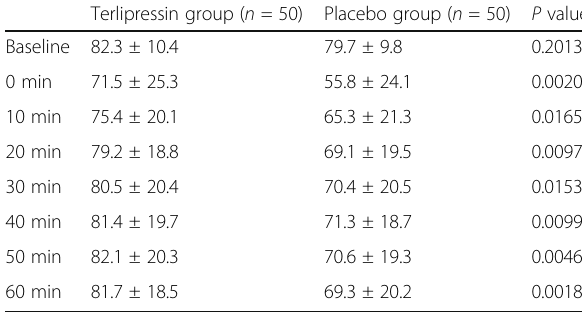
Table 4 Mean arterial blood pressure (mmHg) Terlipressin group ( n = 50) Placebo group ( n = 50) P value Baseline 82.3 ± 10.4